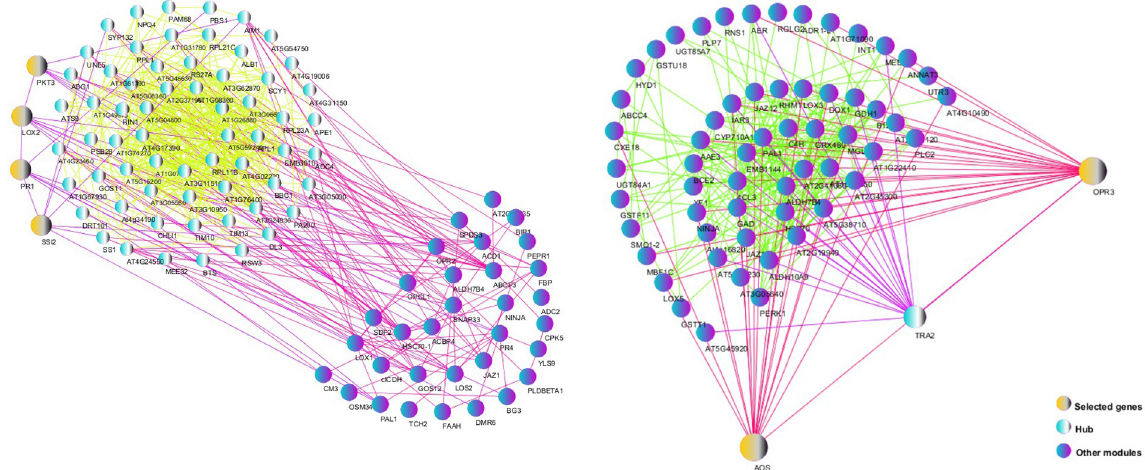
Fig 9. The protein-protein interaction network of hub genes and DEGs using STRING database and Cytoscape software. (a) The network of interactions among biotic hub genes and the DEGs is showed. (b) The network of interactions among hormonal hub genes and the DEGs is presented. The yellow nodes represent the selected key genes for qPCR validation, blue nodes represent the hub genes, and the purple nodes represent the most connected genes to the key genes in the network.